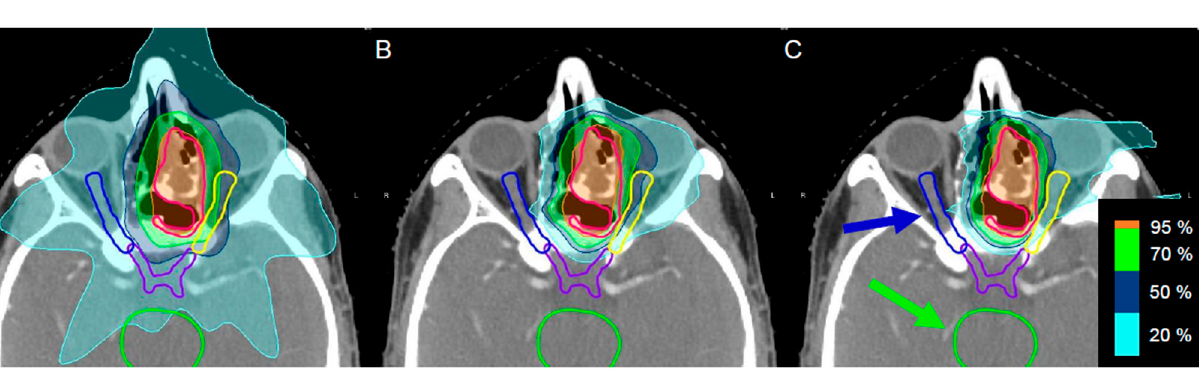
Figure 2. The percentage depth dose curves of the ( A ) proton and ( B ) C-ion SOBP used for cell irradiations. A very good agreement between the predicted dose distributions of the treatment plan- ning system (TPS) and Monte Carlo (MC) simulation was achieved. The respective LET spectrum shows the increase with increasing depth in water. C-ions have a much higher LET than protons, which is reflected by the scale of the mirrored y-axis (25 keV/ μ m versus 250 keV/ μ m). For protons, the LET after the fall-off region has no physical meaning as no particles are delivered beyond this depth. 2.2. Cell Biological Alterations after Photon, Proton, and C-Ions IR in Human Chondrosarcoma Cells To demonstrate the cell biological influence of the different types of IR, human chon- drosarcoma cells were irradiated with 4 Gy X-ray/proton/C-ions and cell proliferation and viability were measured. The real-time xCELLigence system clearly showed that cell pro- liferation is inhibited according to the increasing LET (=ionisation density) levels of the IR modes (X-ray < proton < C-ions) (Figure 3A). The same effect can be observed in endpoint measurements of viability after 24–168 h (Figure 3B).